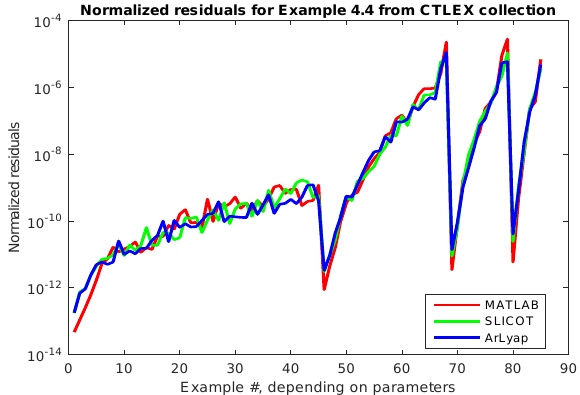
Figure 7. Normalized residuals for CTLEX 4.4 series of